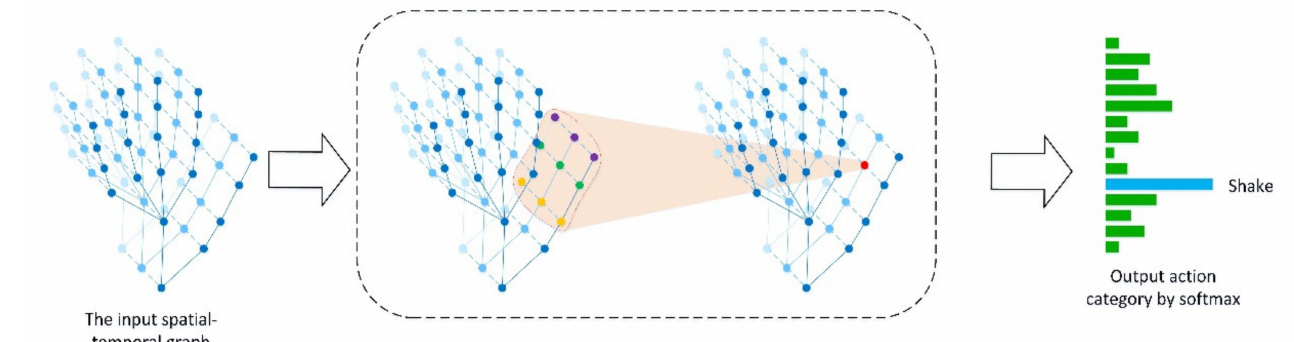
Figure 7. NST-GCN